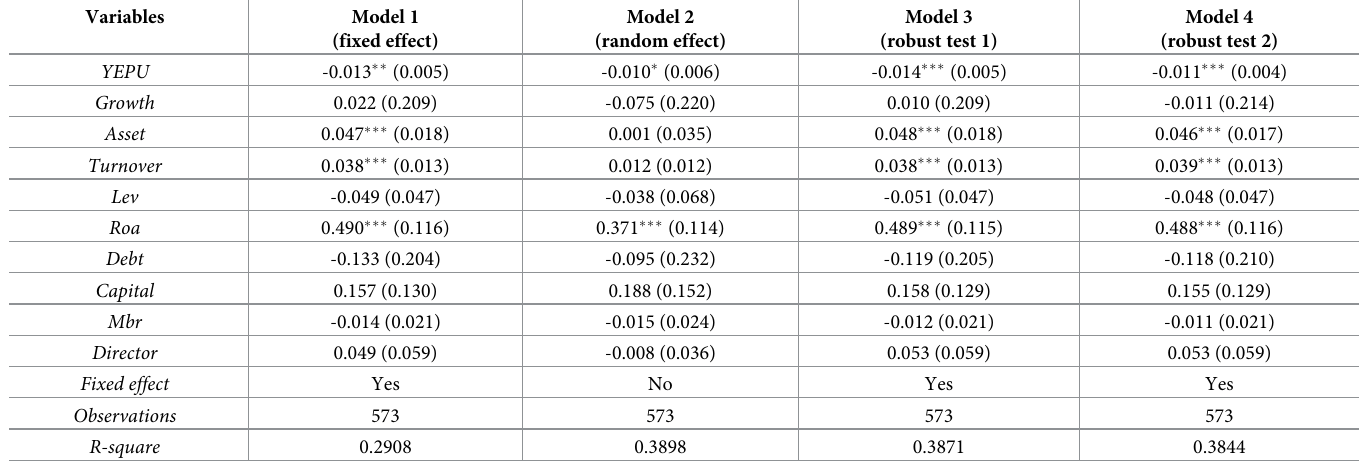
Table 2. Results of the base